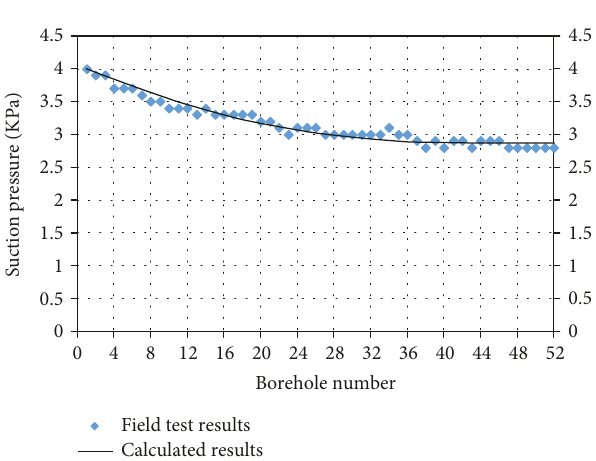
Figure 4: Comparison between fi eld test results and model- calculated results.